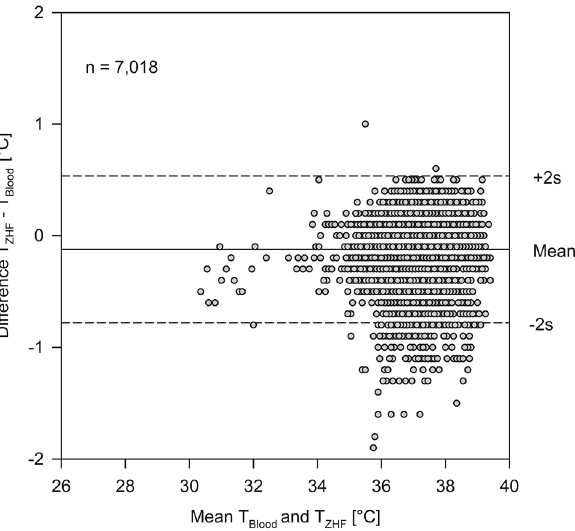
Figure 1. Bland–Altman analysis for the zero-heat flux thermometer (T ZHF ) versus blood temperature (T Blood ).